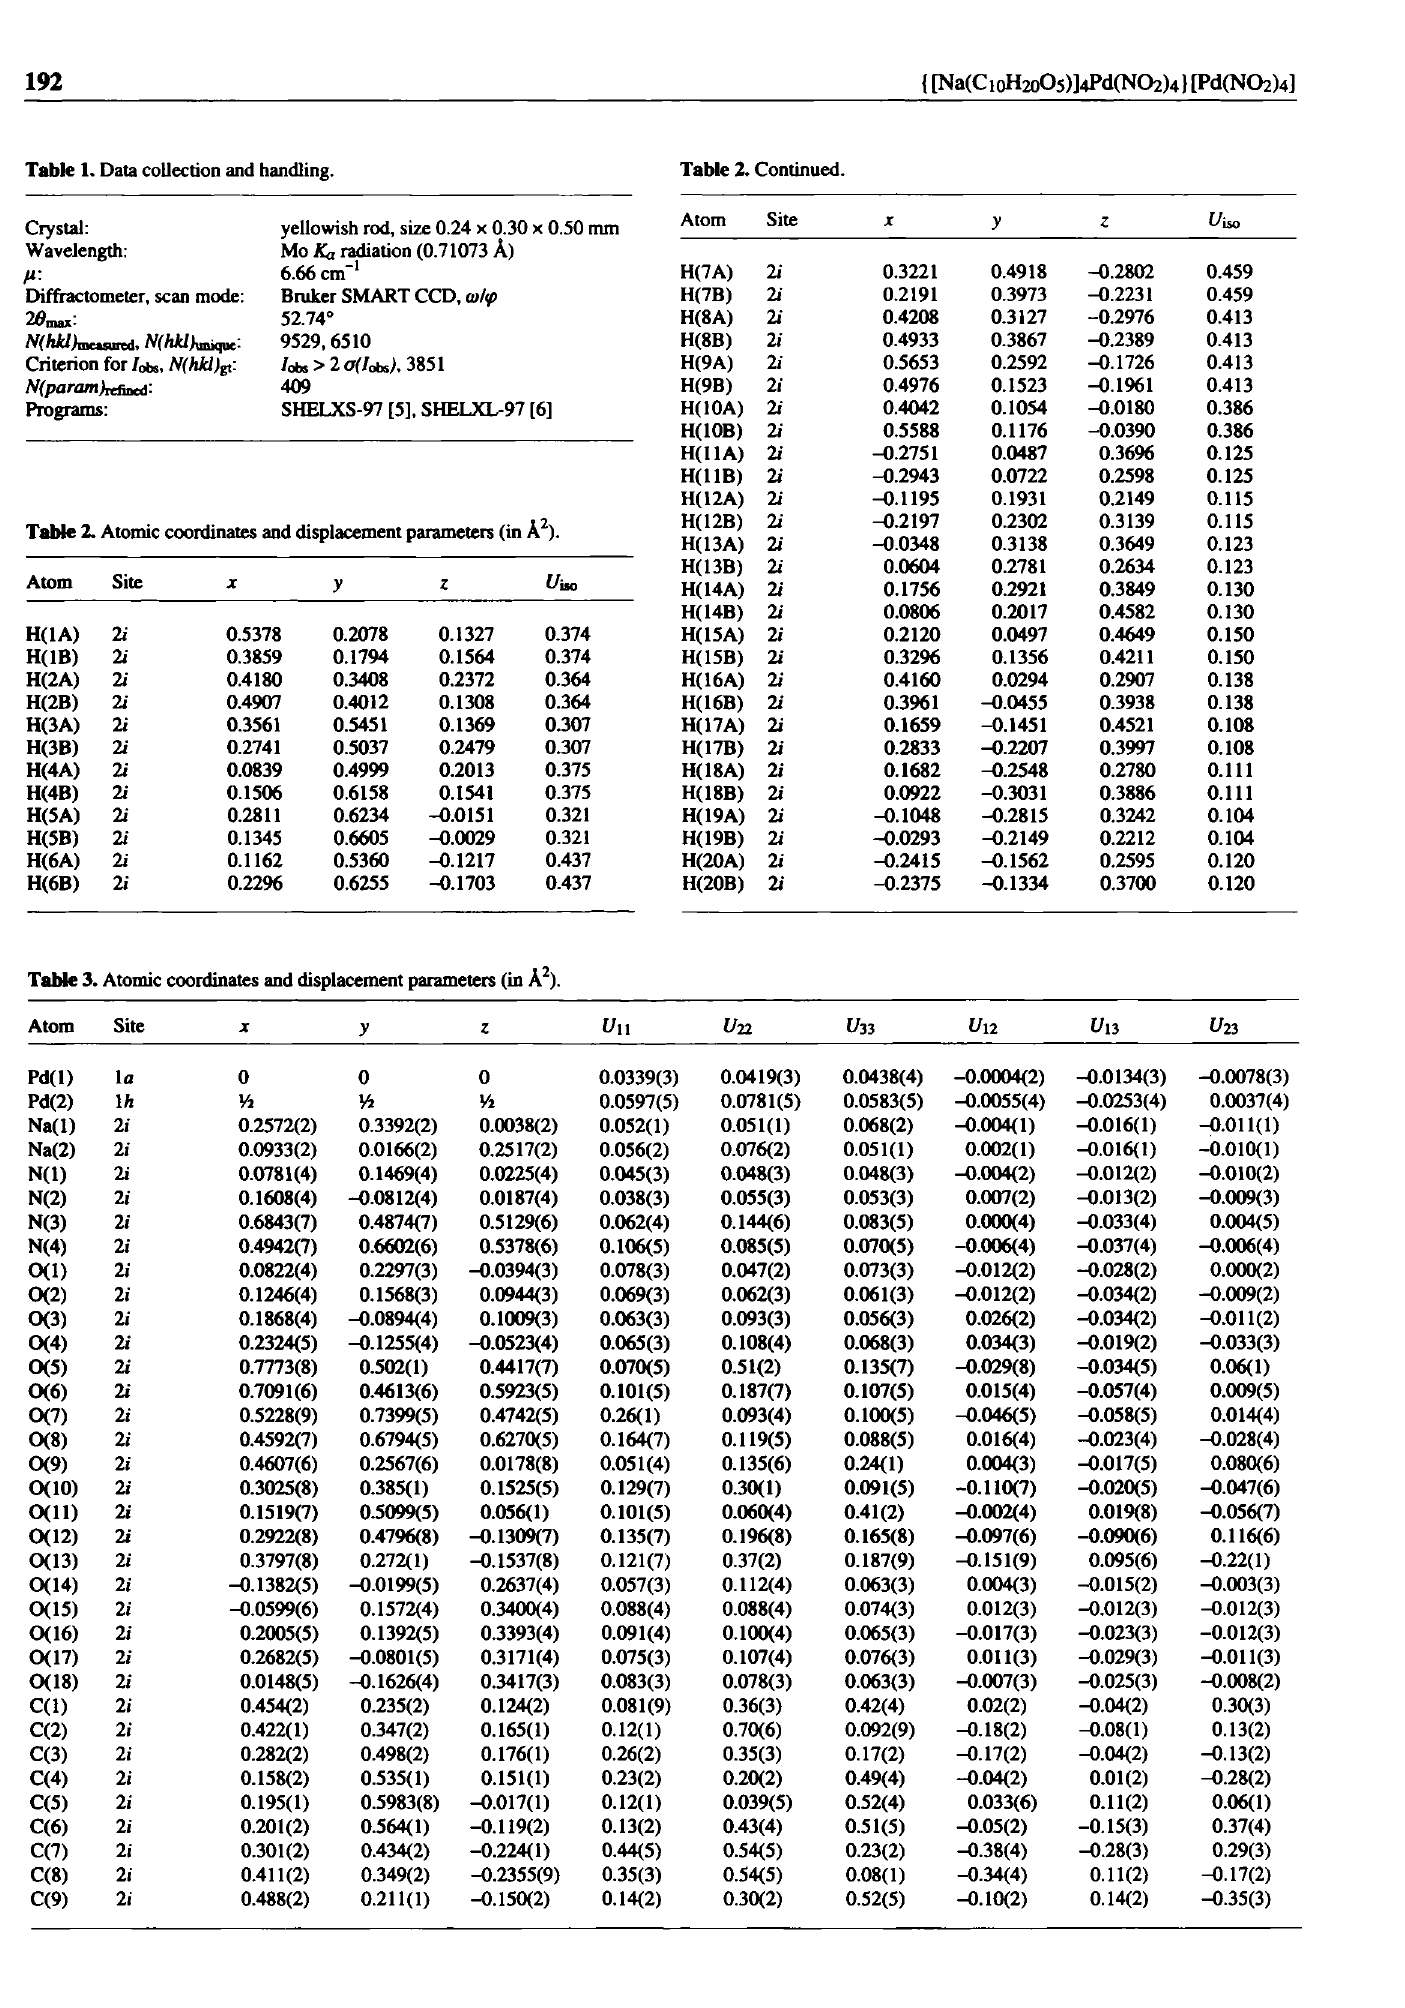
Table 2. Atomic coordinates and displacement parameters (in A 2 ).